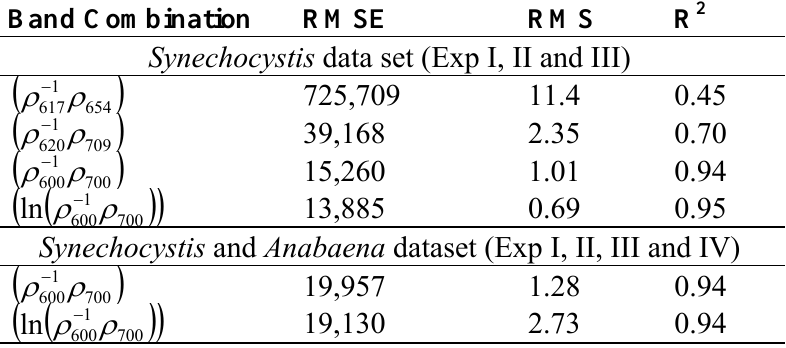
) and slope (a ) with 0 1